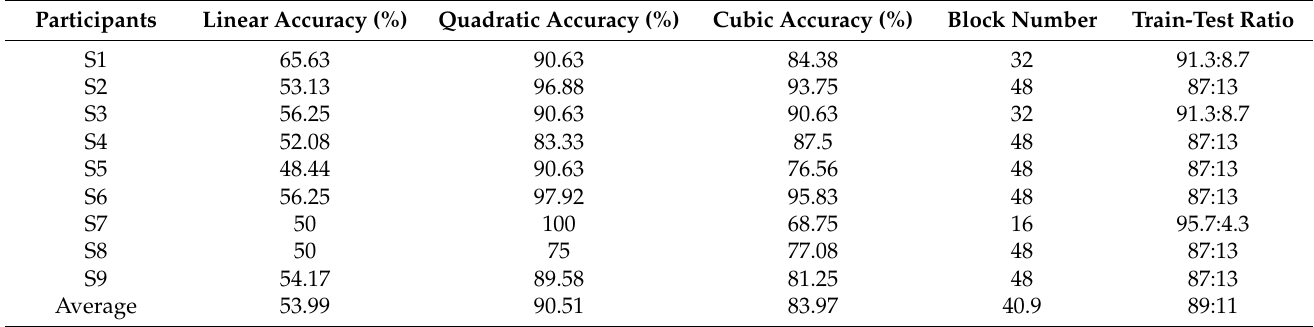
Table 4. Accuracies for individual participants with three kernel